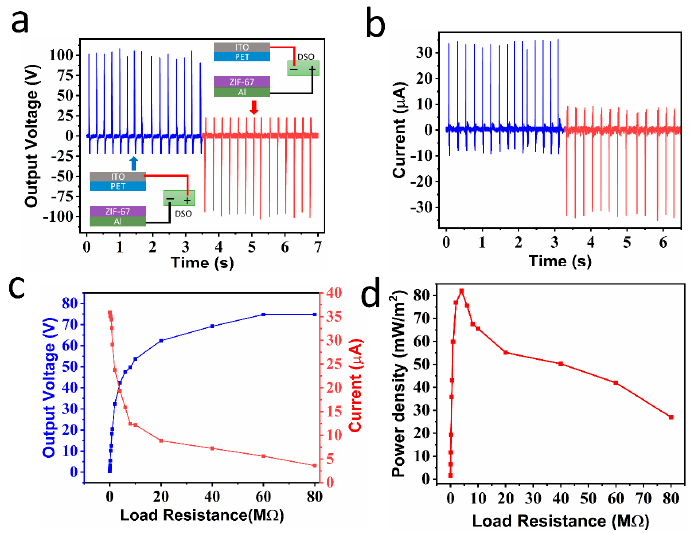
Figure 3 . ( a ) Forward and reverse current, ( b ) forward and reverse voltage, ( c ) voltage and current response at different external loads, and ( d ) power density vs. load resistance of the TENG device (all the measurements were recorded considering a device area of 10 × 10 cm 2 ).